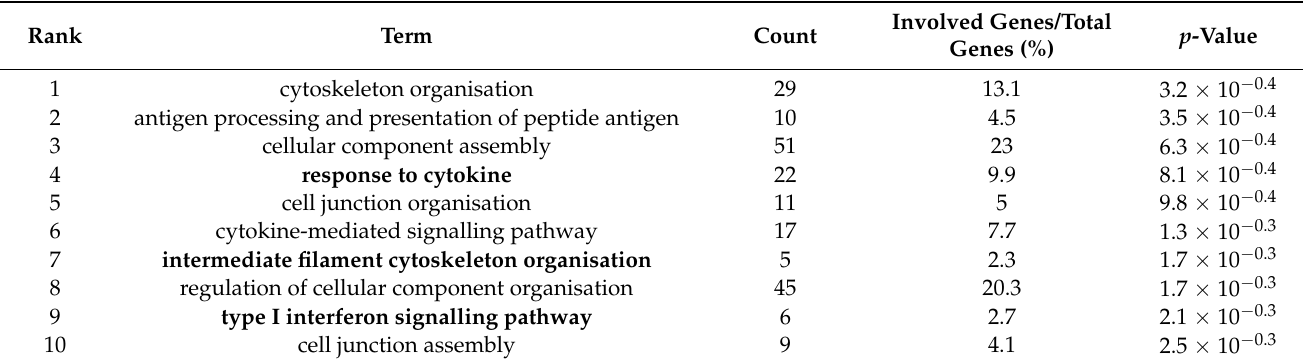
Table 1. Top 10 gene ontology biological functions for proteins with decreased or increased abundance in OVCAR-5 cells. Terms in bold represent those which are represented in both OVCAR-5 and CaOV3 cells.